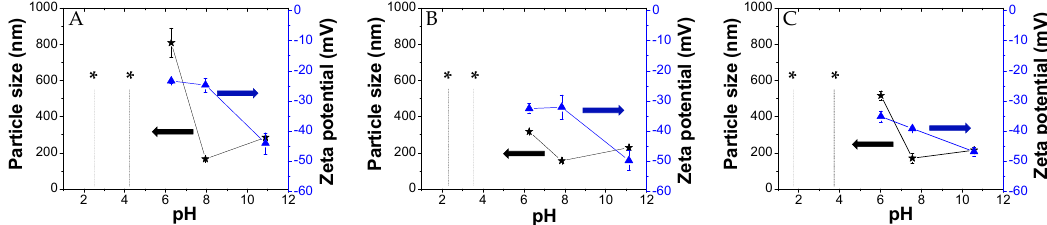
Figure 4. Size and zeta potential of the PKHEDA (1 × 10 ⁻ 4 M)/TPPS systems at different pHs and TPPS concentrations: ( A ) 5 × 10 ⁻ 5 ; ( B ) 1 × 10 − 4 ; ( C ) 2 × 10 ⁻ 4 M; * indicates macroparticle suspensions.